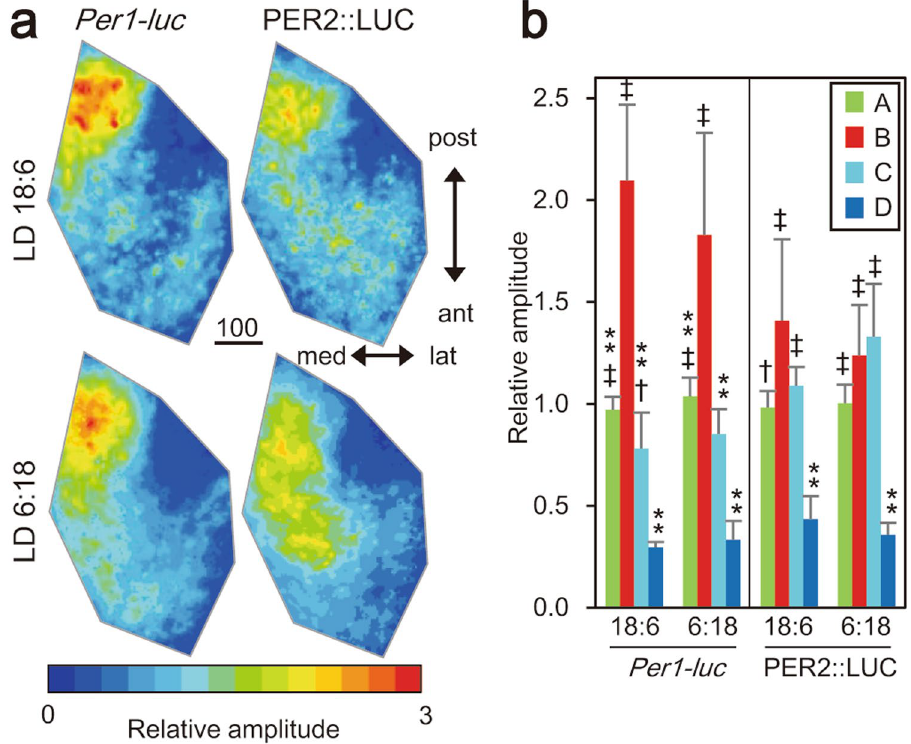
Figure 5. Regional difference in the amplitude of circadian Per1-luc and PER2::LUC. ( a ) Mean amplitude (n = 5) maps for the circadian Per1-luc (left) and PER2::LUC (right) rhythm in LD18:6 (upper) and LD6:18 (lower). Color bars indicate relative amplitudes expressed in a ratio to the mean of each SCN slice. Scale bar, 100 μ m. ( b ) Mean relative amplitudes with SD in the four SCN regions for the circadian Per1-luc and PER2::LUC rhythms. ** P < 0.01, vs. region B, ‡ P < 0.01, † P < 0.05 vs. region D, one-way ANOVA with a post- hoc Tukey-Kramer